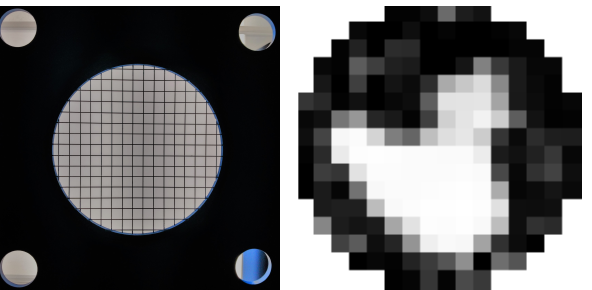
Figure 3. ( Left ) Picture of the wires of one wire-mesh sensor. The two planes of parallel wires are installed perpendicular to each other, creating a virtual grid of points; ( Right ) Volume fraction of gas measured by the sensor, with the gas fraction proportional to the grayscale of the pixel (pure liquid is black, and pure gas is